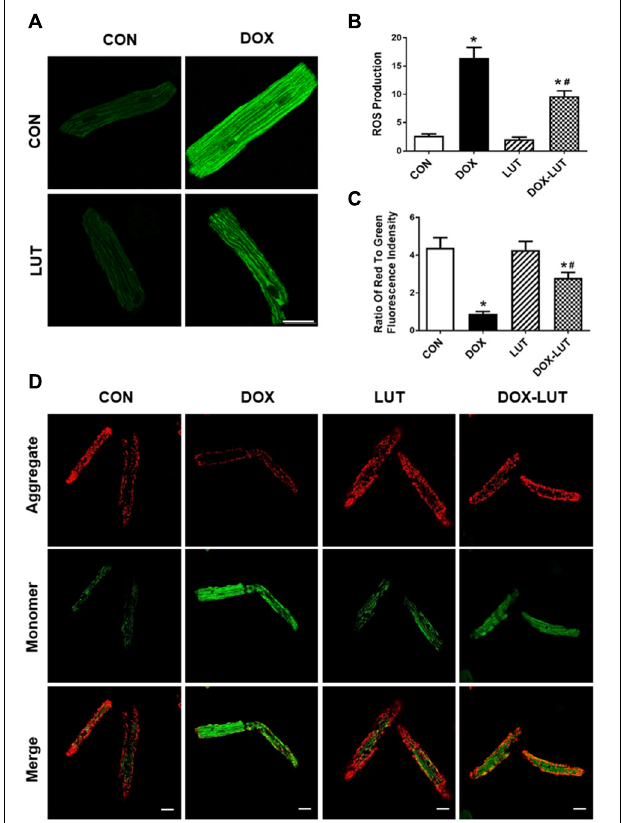
FIGURE 3 | Effect of luteolin on doxorubicin-induced cardiomyocyte mitochondrial injury. (A) Representative fluorescence images of AMCMs (original magnification = 630 × ) showing ROS production in cardiomyocytes after exposure of doxorubicin and luteolin. (B) Pooled data of ROS production from nine fields per group. (C,D) Representative fluorescence images and quantitative analysis of cardiomyocyte (cid:49) ψ m using JC-1 fluorescence from nine fields (original magnification = 400 × ). Scale bars = 25 µ m. Mean ± SEM, n = 3 independent experiments in duplicates per group, * p < 0.05 vs. CON group, # p < 0.05 vs. DOX